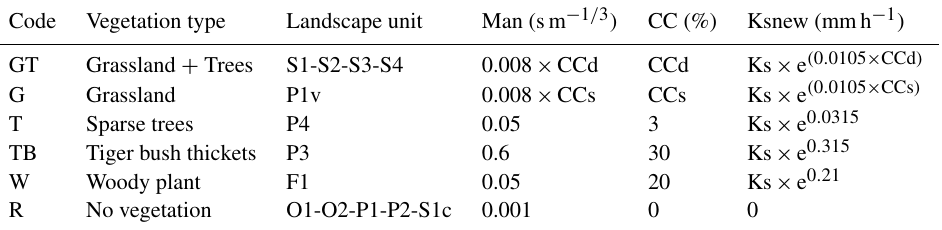
Table 4. Summary of the different land cover types and their hydrological parameters (Man: Manning’s roughness coefficient; CC: canopy cover; and Ksnew: saturated hydraulic conductivity